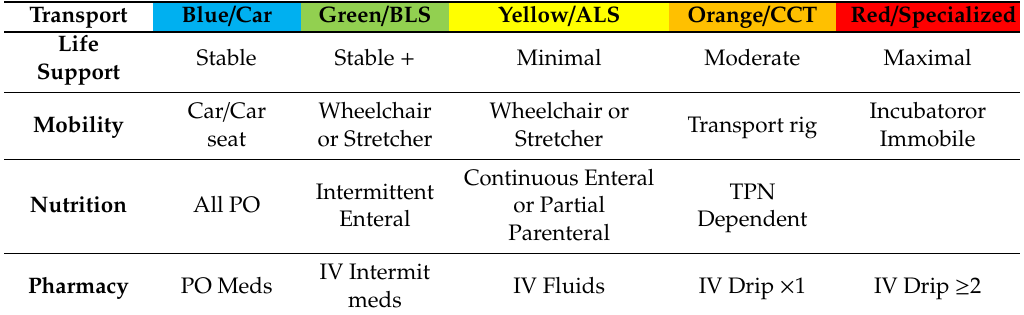
Table 1. Triage by resource allocation for inpatients (TRAIN) tool. (Adapted from Dr. Lin’s Triage by Resource Allocation for Inpatients: A Novel Disaster Triage Tool for Hospitalized Pediatric Patients , 2018) [5]. Transport Blue / Car Green / BLS Yellow / ALS Orange / CCT Red / Specialized Stable Stable + Minimal Moderate